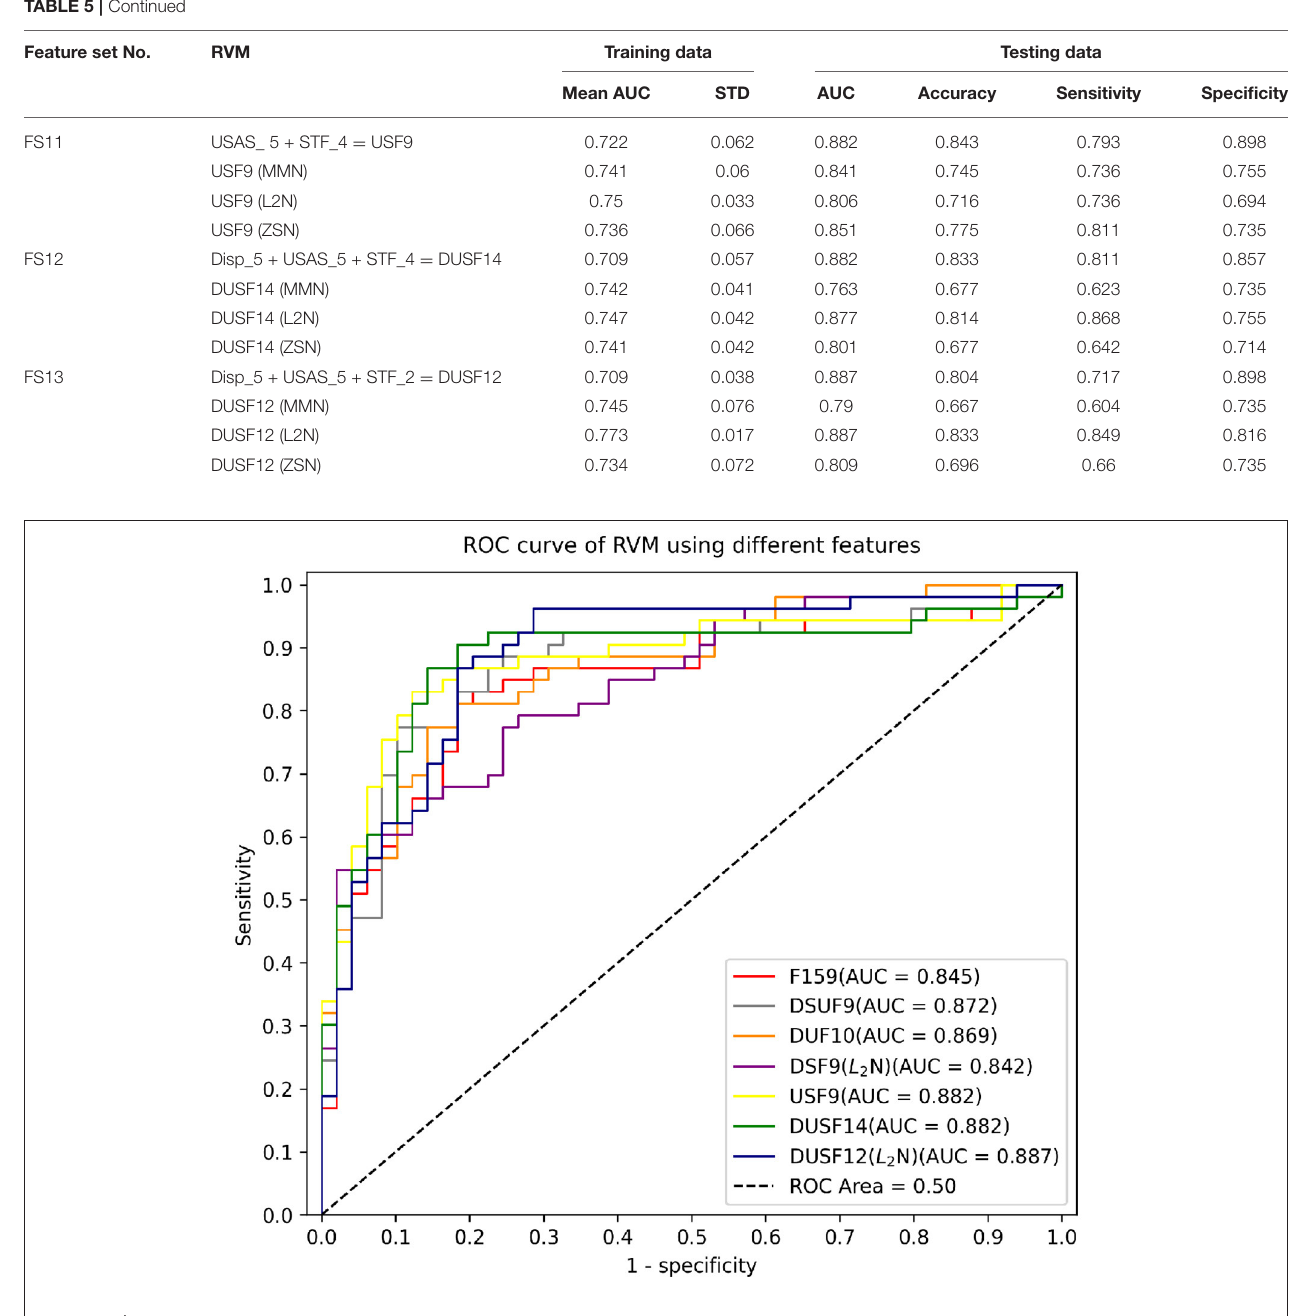
FIGURE 2 | AUC of RVMs on testing data using different feature